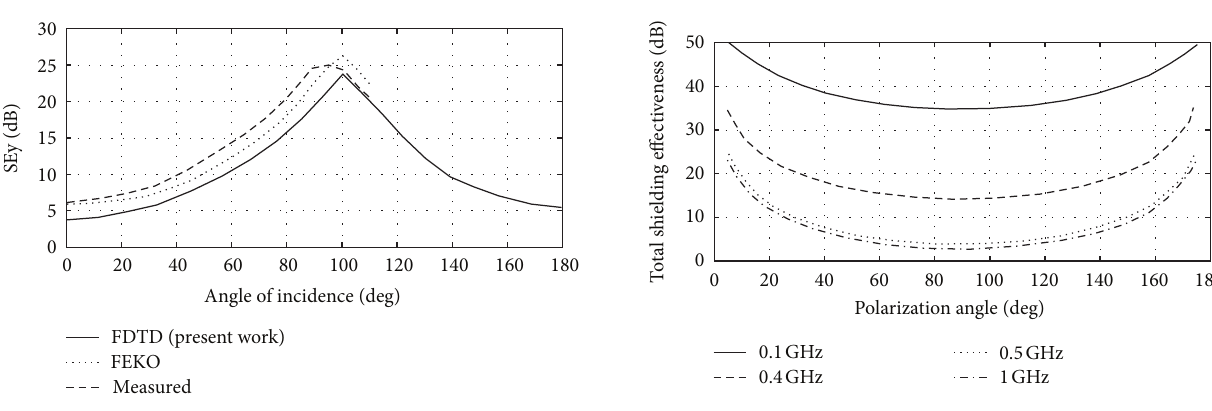
F 8: Shielding effectiveness versus polarization angle the incident plane wave for a 30 box-shaped enclosure 3cm ) against the aperture at different with 20 MHz. × × × (𝜃𝜃 𝑖𝑖 ) 𝑓𝑓 𝑓 𝑓𝑓𝑓